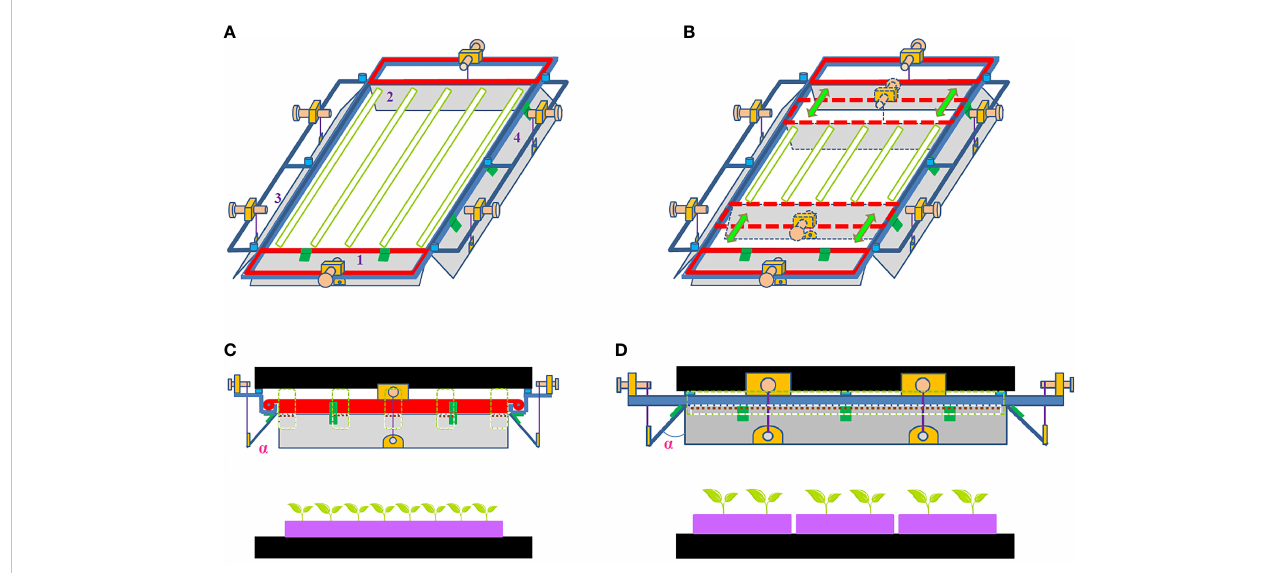
FIGURE 1 Adjustable lampshade-type re fl ector (ALR). (A) Three-dimensional schematic view of ALR with fi ve LED tubes placed inside, illustrating its application in an indoor farm rack (IFR) lighting system. (B) Three-dimensional schematic view of ALR with fi ve shorter LED tubes placed inside, illustrating its advantages for application in an IFR lighting system. (C) Front-width-side view of ALR installed at IFR. (D) Left-length-side view of ALR installed at IFR. a is the included angle of the re fl ective board. 1 and 2 in (A) stand for the fi rst and second re fl ective boards coupled to the width sides of the main frame, while 3 and 4 in (A) represent the third and fourth re fl ective boards coupled to the length sides of the main